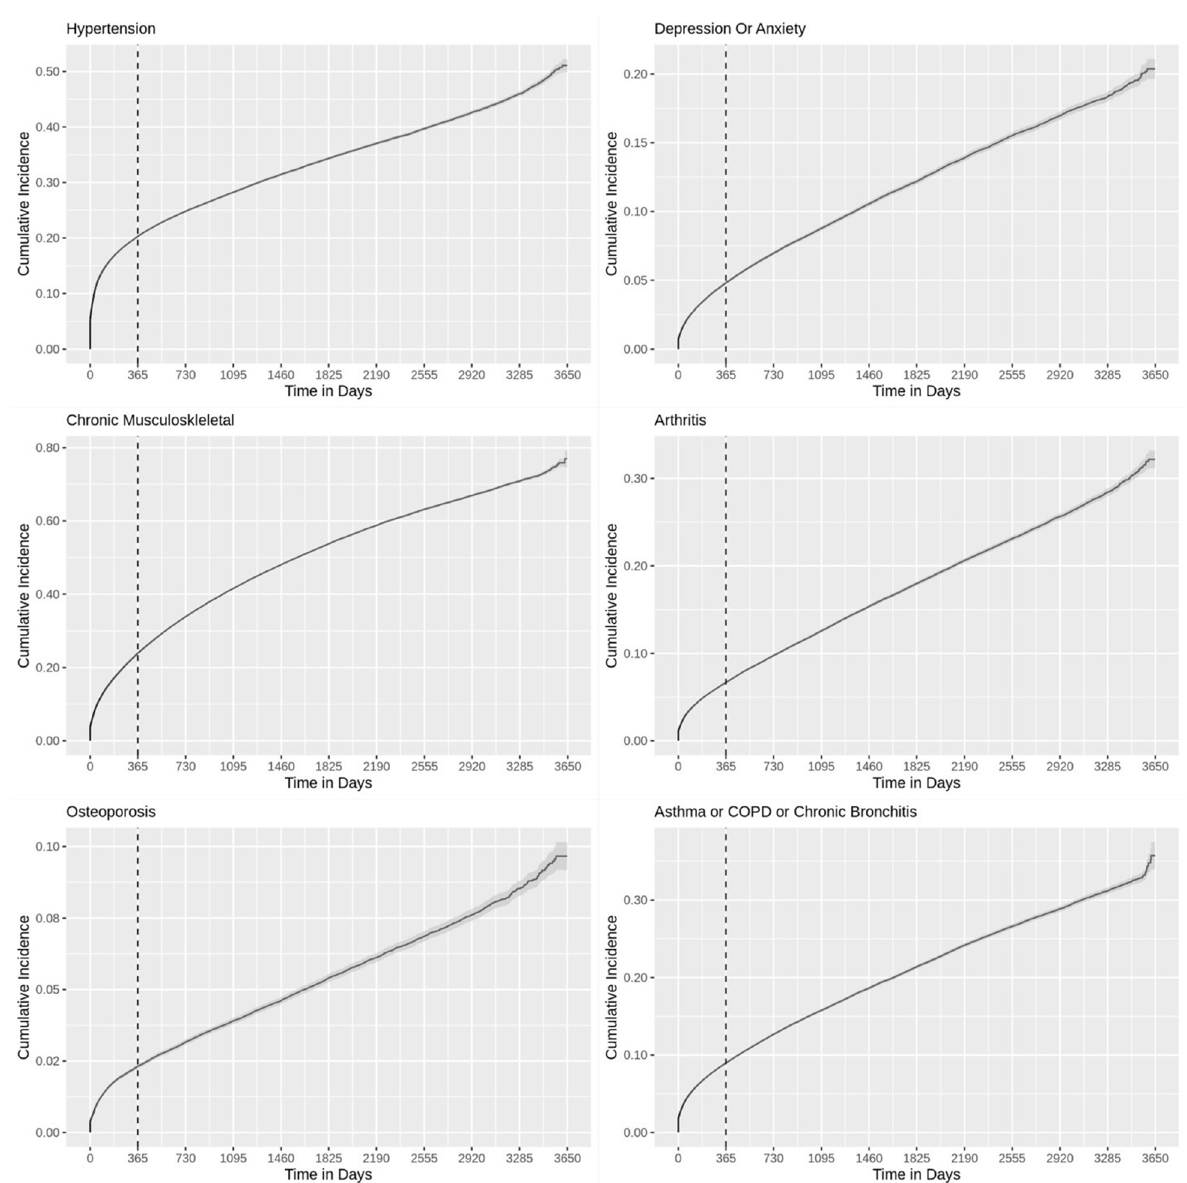
Supplementary Figure 3: Cumulative